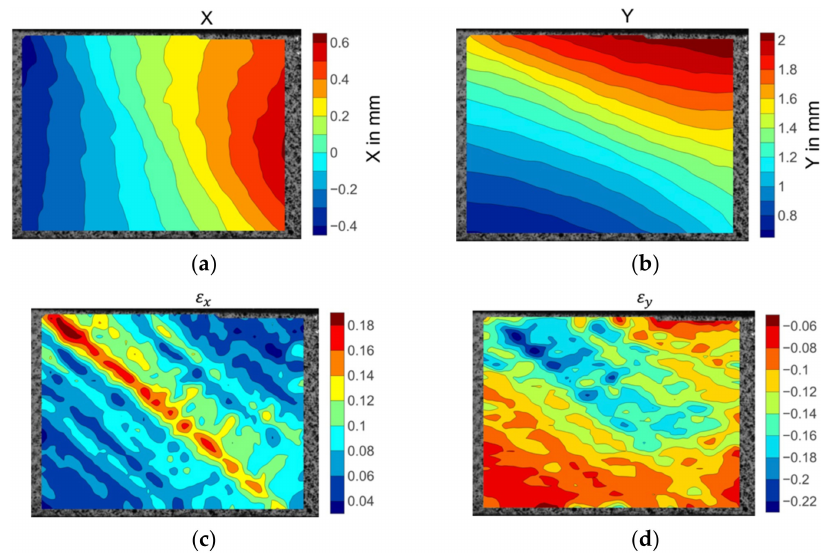
Figure 11. The displacement and strain field contour plots of the 45 ◦ off-axis specimen: ( a ) Displace- ment in the X direction; ( b ) displacement in the Y direction; ( c ) strain in the X direction; ( d ) strain in the Y direction.